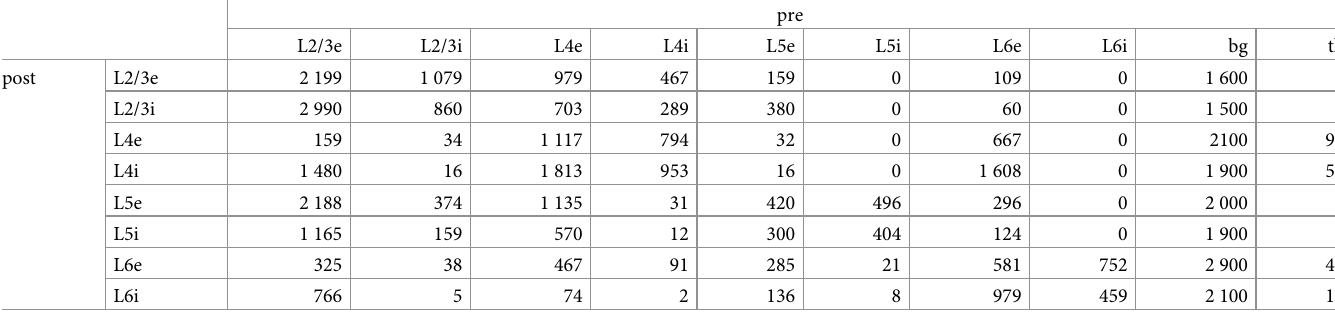
Table 3. In-degrees for individual projections between pre- and postsynaptic